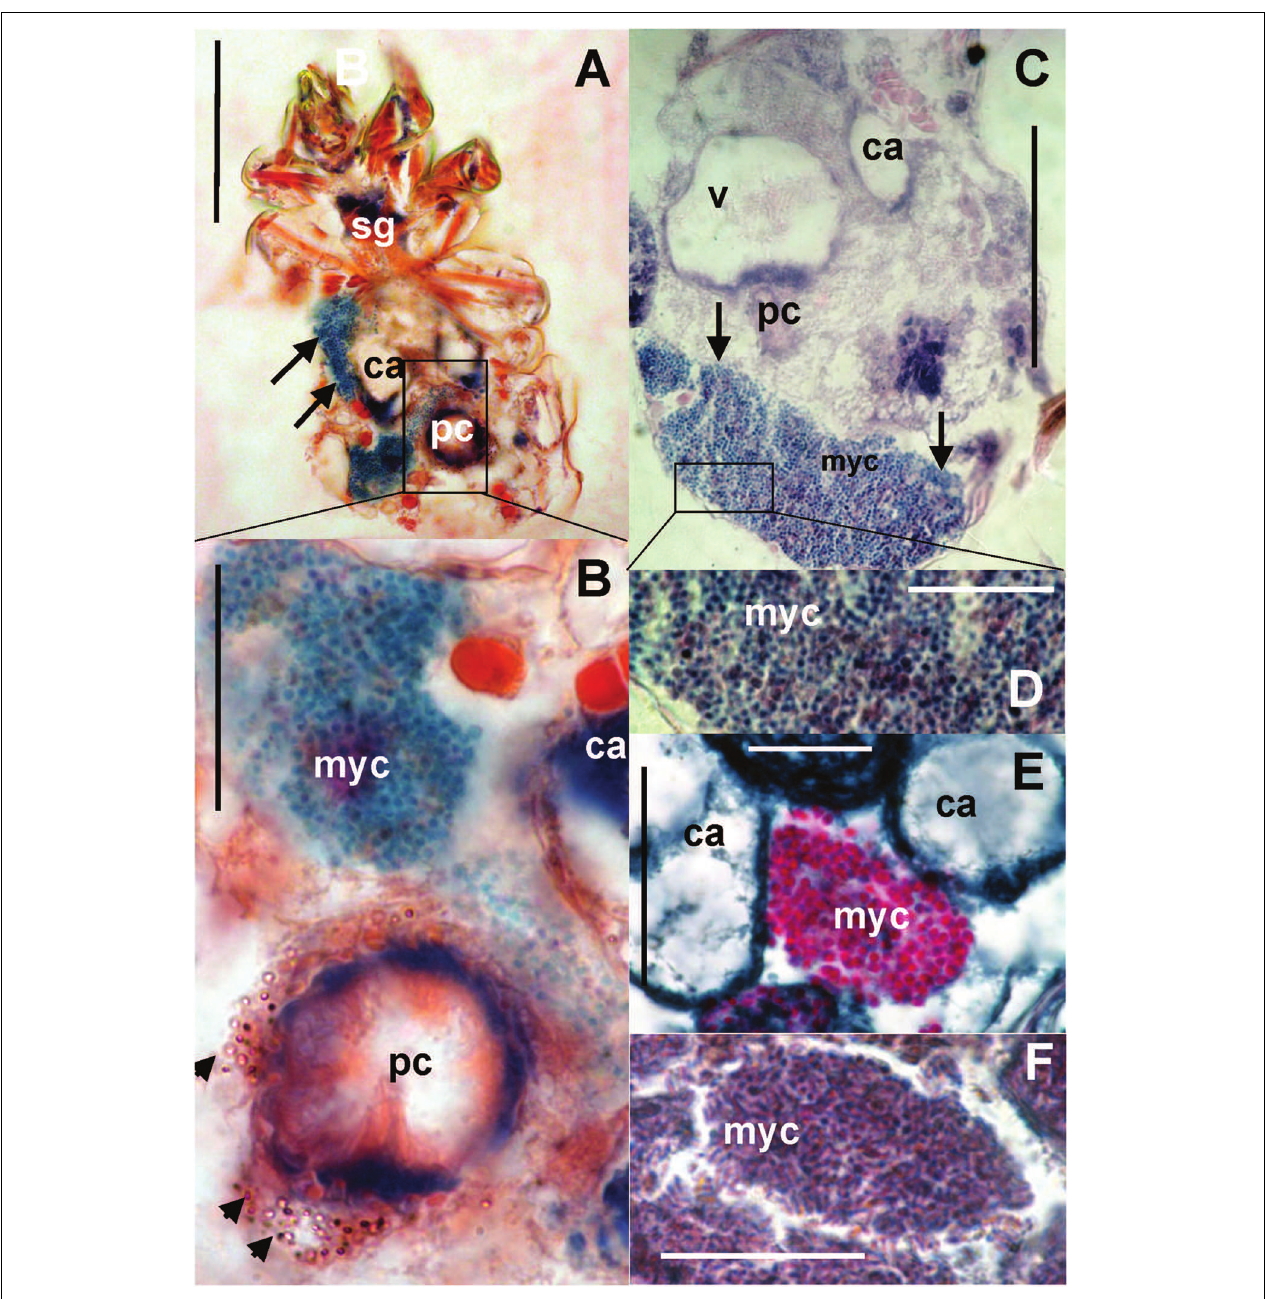
FIGURE 8 | Histological sections of T. putrescentiae : (A) Total view of T. putrescentiae with bacteriocyte (arrows); (B) details of the previous image; the arrows point to guanine crystals near the post-colon; (C) sagittal section of the mite body with bacteriocyte (arrows); (E) details of the previous image with spherical bacteria; (F) localization of bacteriocytes with spherical bacteria, (F) details of the bacteriocyte with rod-shaped bacteria. Staining: (A,B) Mann Dominici, (C,D) Ziehl–Neelsen, (E,F) Masson’s triple stain; Scales. (A,C) 100 µ m, (D–F) 25 µ m. ca, caecum; fb, food bolus; myc, bacteriocyte; pc, post-colon; sg,